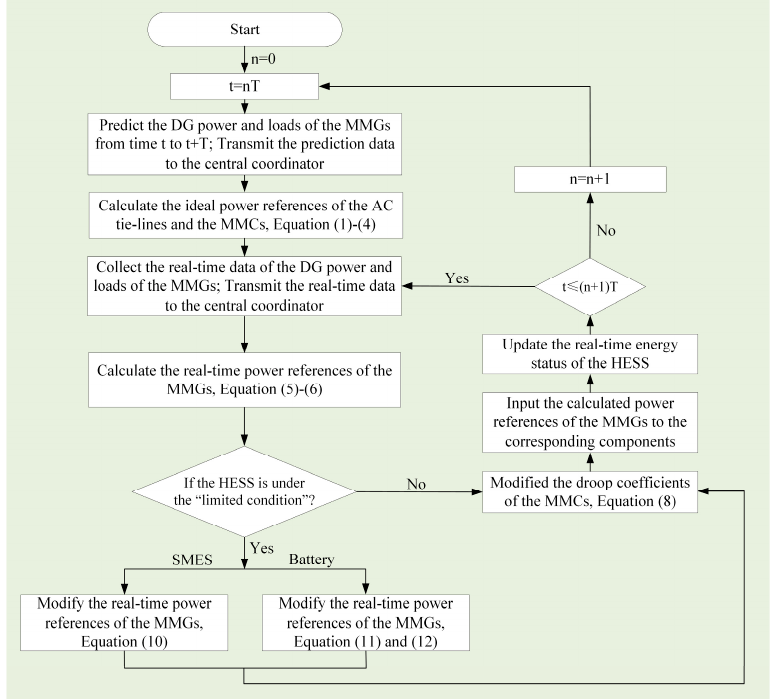
Figure 5. Algorithm of the proposed multi-layer coordinated control scheme.